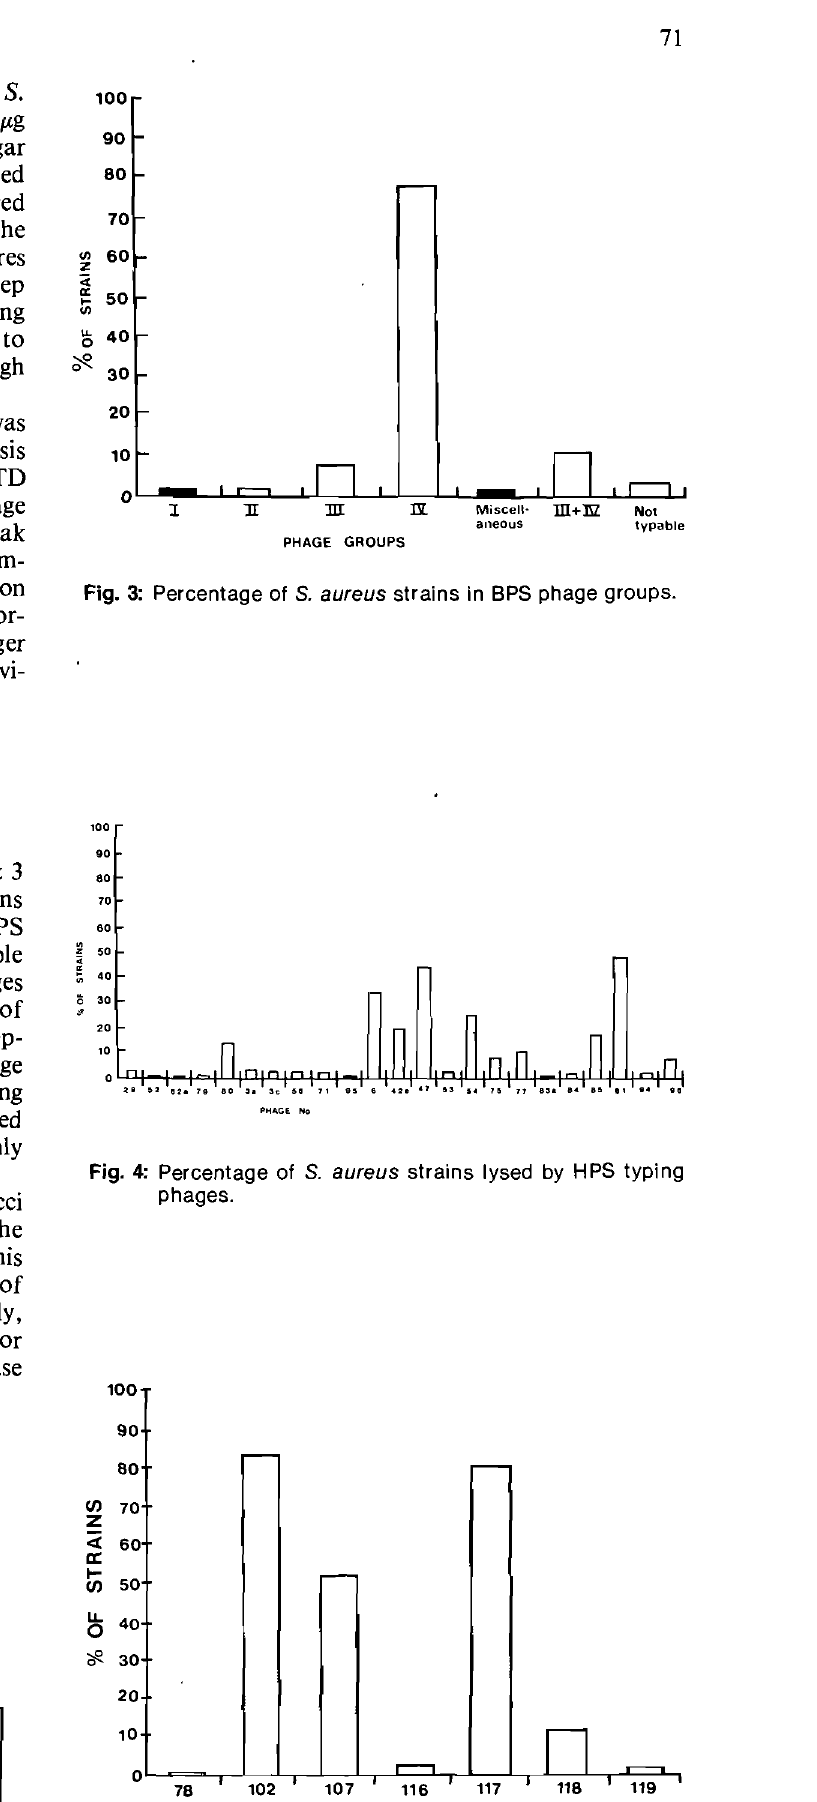
Fig. 5: Percentage of S. aureus strains lysed by BPS typing